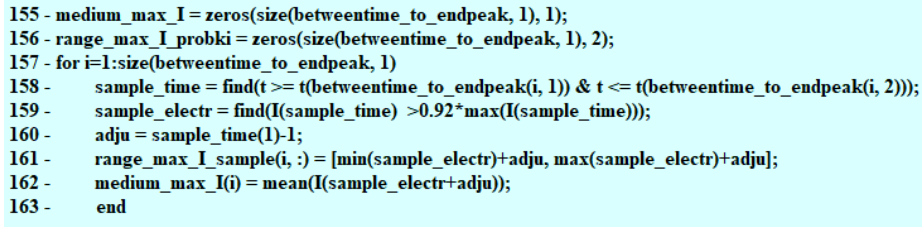
Figure 8. Final part of the search for the needle lifting phase.